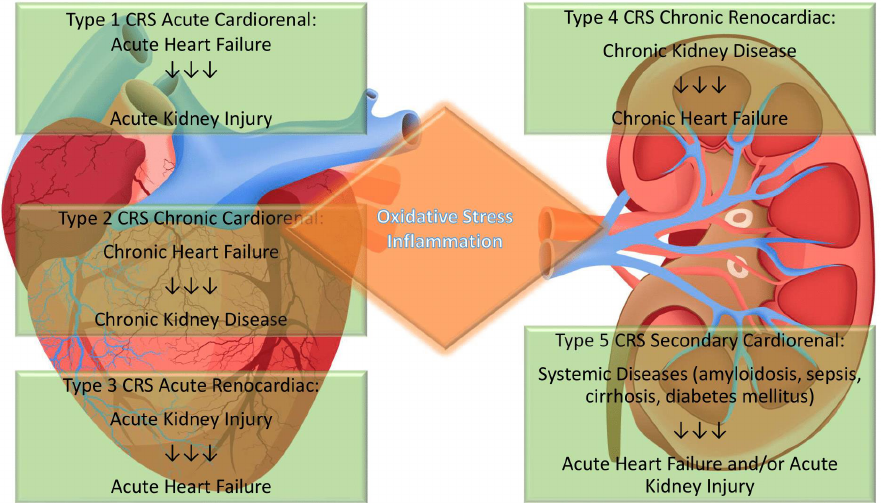
Figure 1. Different Types of Cardiorenal Syndromes. CRS presents five subtypes characterized by the influence of chronic or acute dysfunction of one organ on another. The acute dialysis quality initiative classification of CRS is helpful to drive the clinicians to the best therapeutic strategies depending on the primum movens of the syndrome. The complex interconnection of this condi- tion is characterized by oxidative stress and inflammation-driven